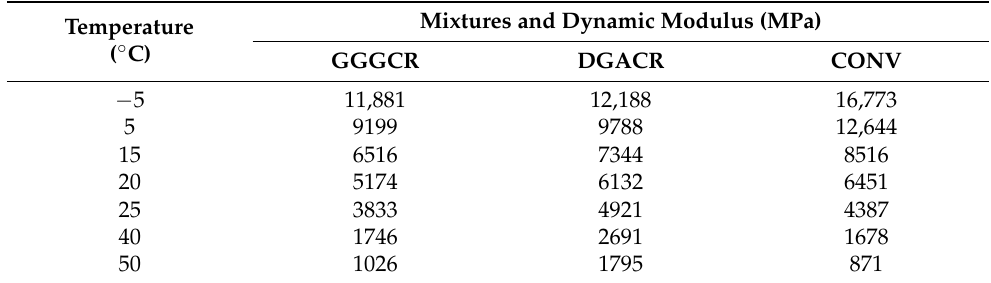
Table 6. Cracked asphalt mixture surface modulus calculated using Equations (3) and (4).